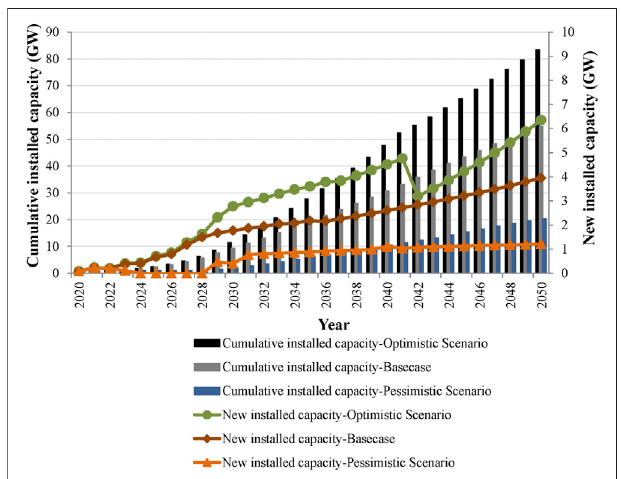
FIGURE 12 | Comparison of optimistic, basic, and pessimistic